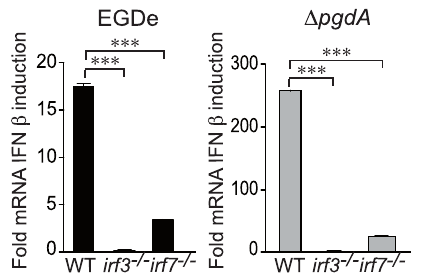
Figure 6. IFN- b response to Listeria is mediated by IRF3 and IRF7 in peritoneal macrophages. PEM from WT C57BL/6J, irf3 2 / 2 and irf7 2 / 2 mice were infected with the parental EGDe strain (black bars) or the D pgdA mutant (grey bars). 4 h post-infection, mRNA was isolated and the IFN- b induction was measured by qRT-PCR. Data are mean 6 SD (***, p , 0.0001, n =3).